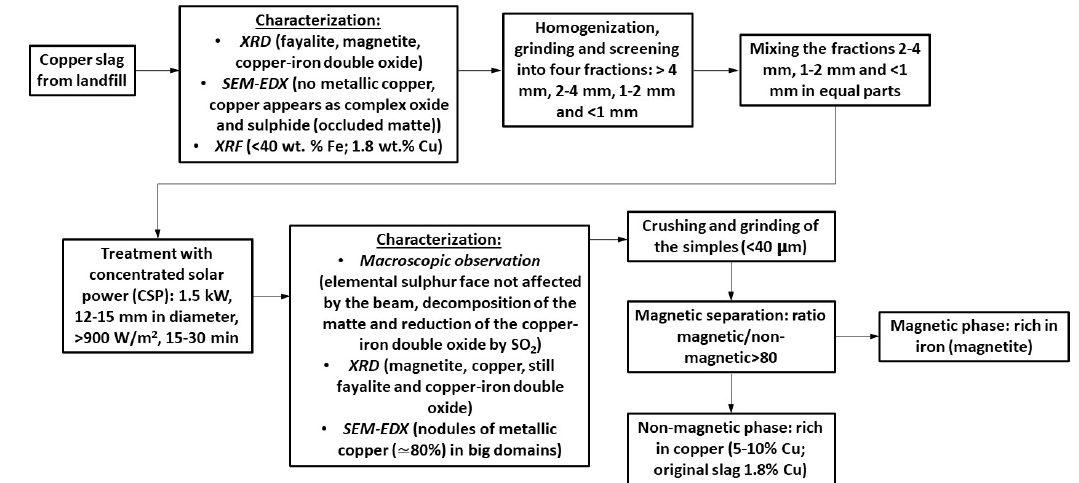
Figure 2. Flow-sheet for the process to examine Cu tailings using CSP.